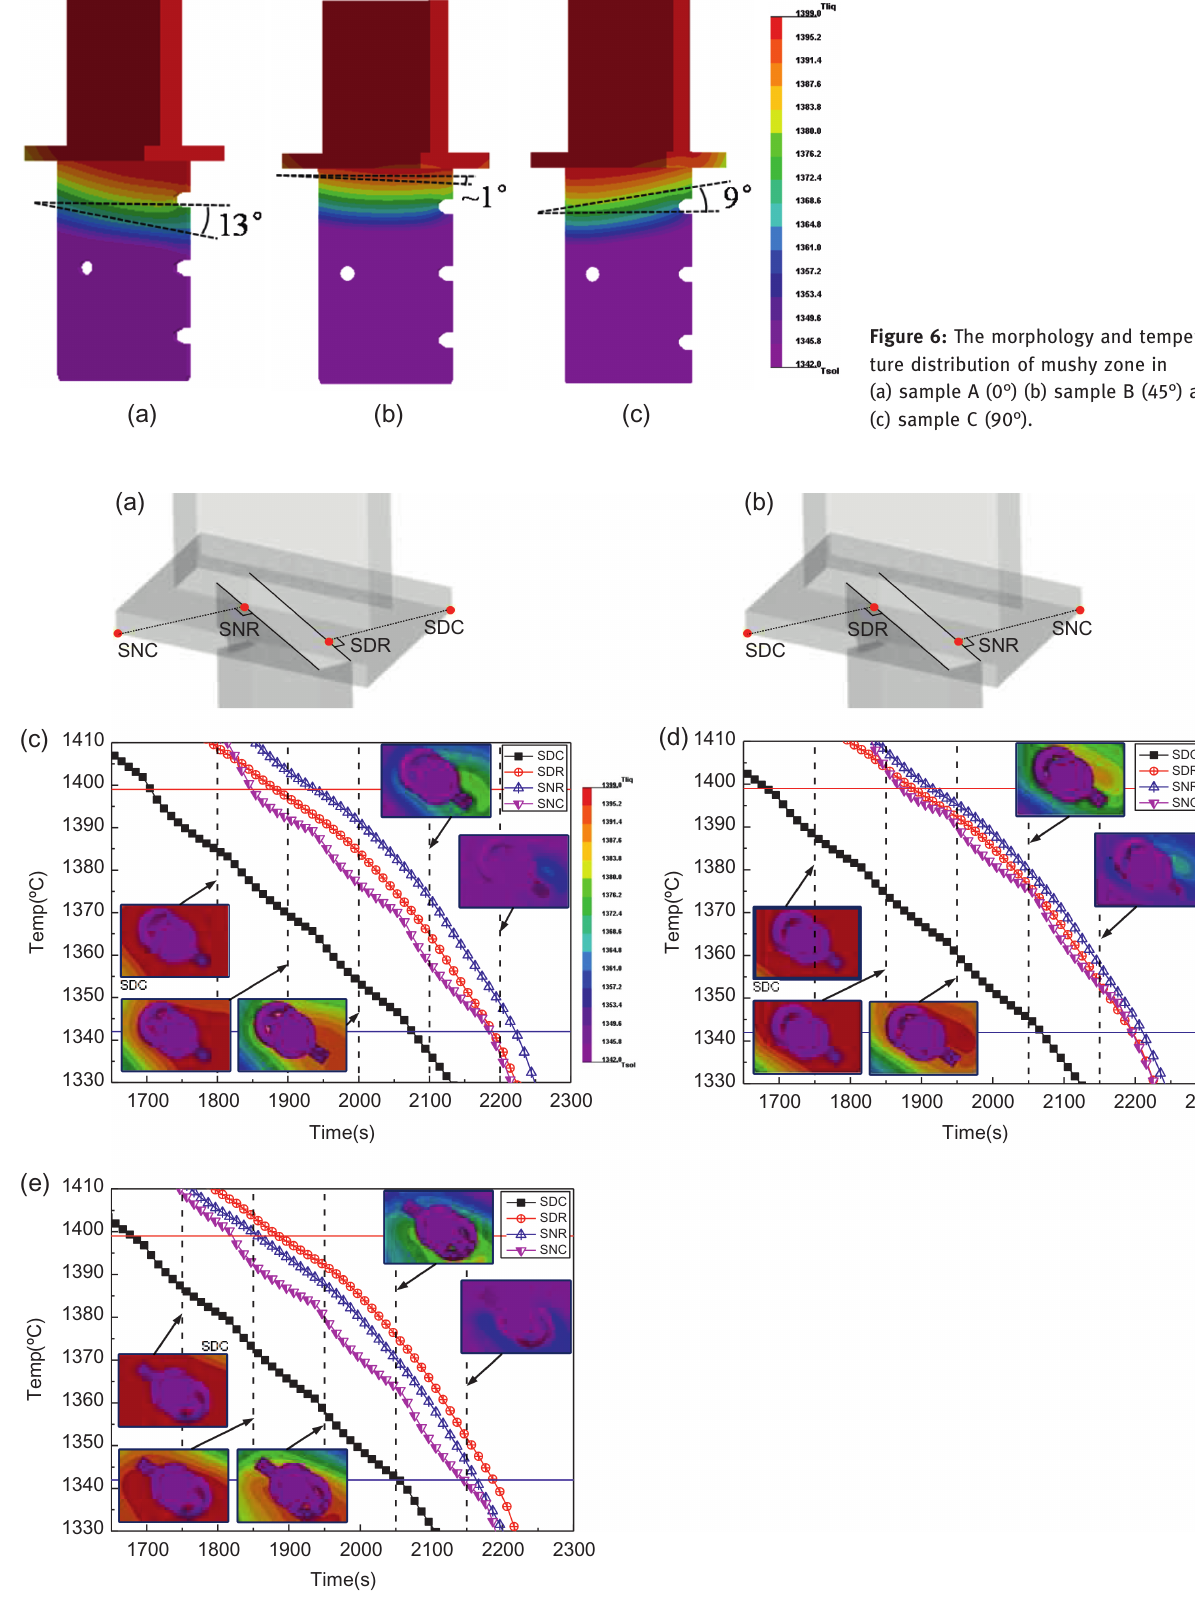
Figure 7: Temperature varies versus time in four specified points that located in the platform of sample (a) (c) A, (a) (d) B and (b) (e)